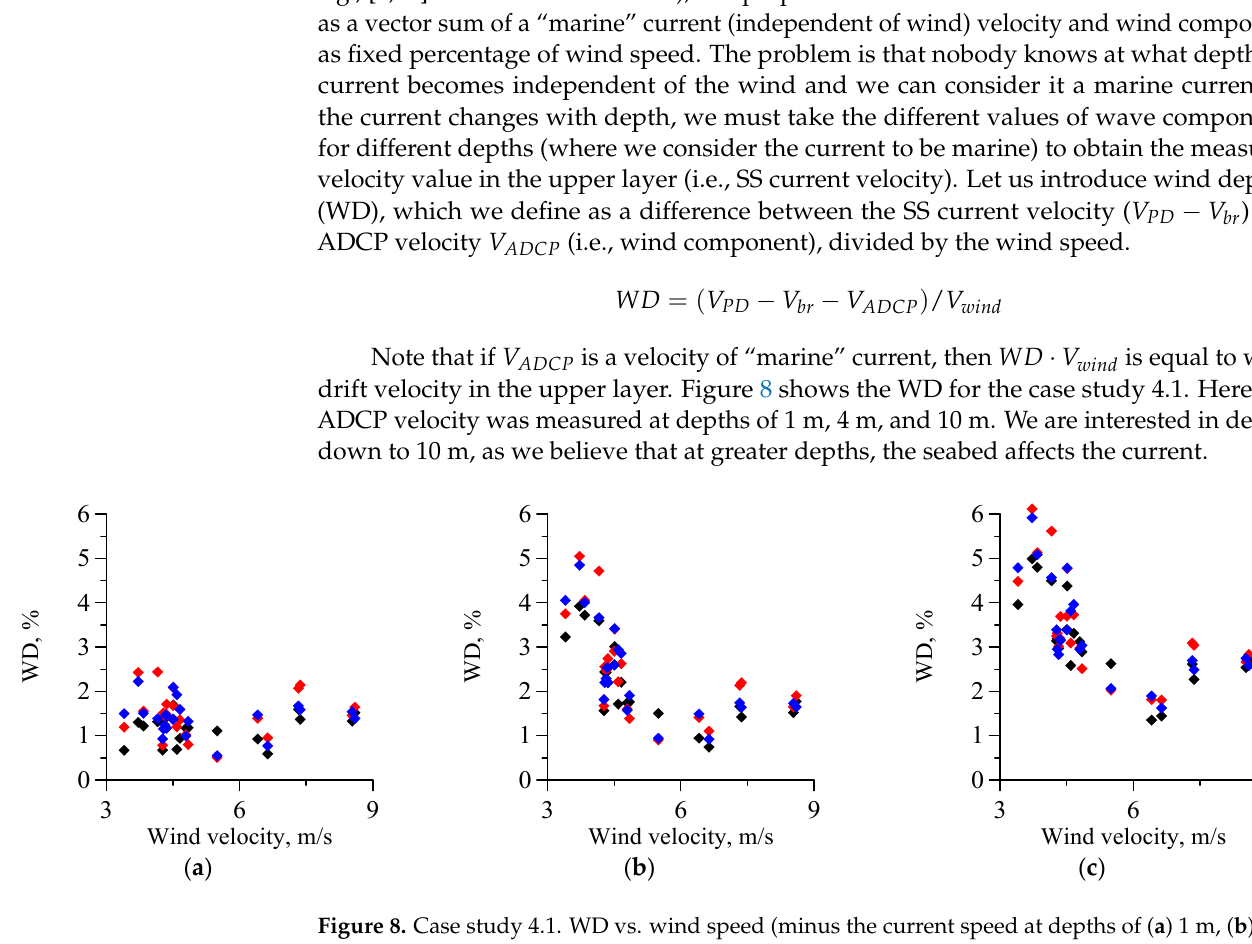
11 of 15 Figure 7. Subsurface current velocities vs. wind speeds (from Figure 4). Black symbols—S-band,